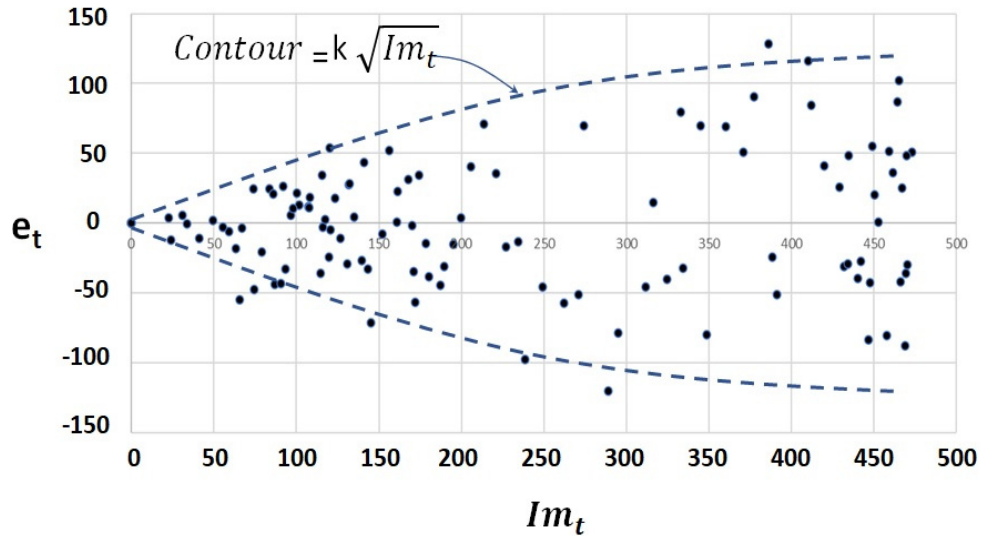
Figure A2. Scatter plot diagram of e t vs. Im t .